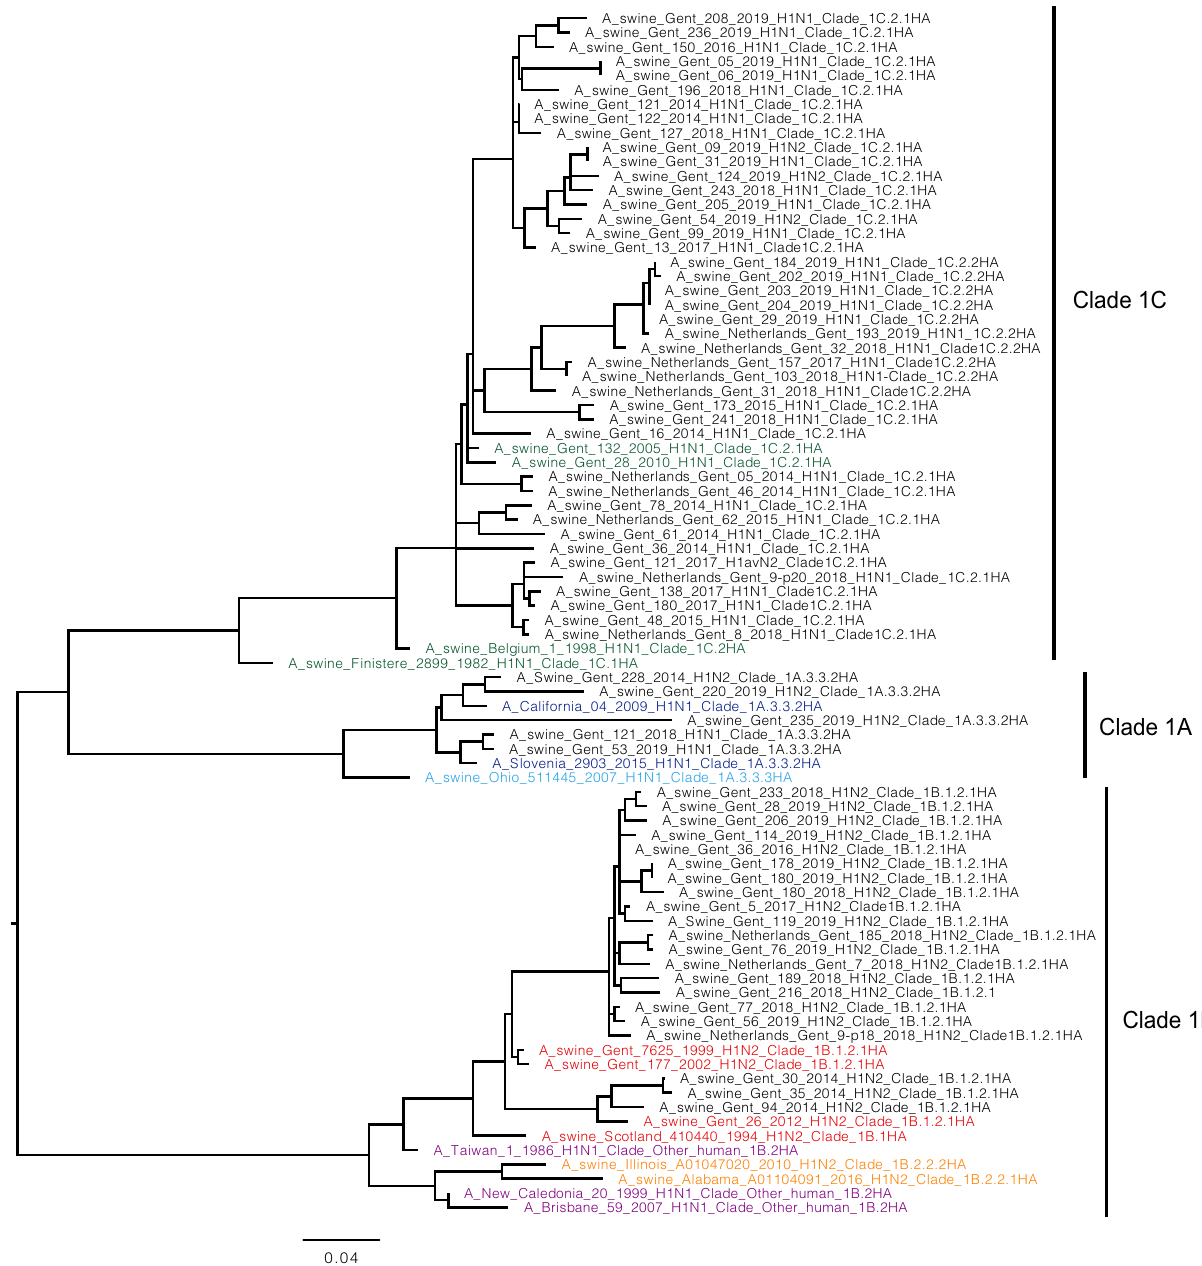
Figure 2. Phylogenetic tree of H1 swIAV isolates and reference viruses. HA1 amino acid sequences from clades 1A, 1B and 1C of H1 influenza A viruses were aligned using the MAFFT web bioinformatics framework 35 . The constructed tree was presented and edited with FigTree V1.4.4 software (v1.4.4). The names of the isolates are shown in black while those of the reference viruses are colored according to their lineages: EU H1av (green),